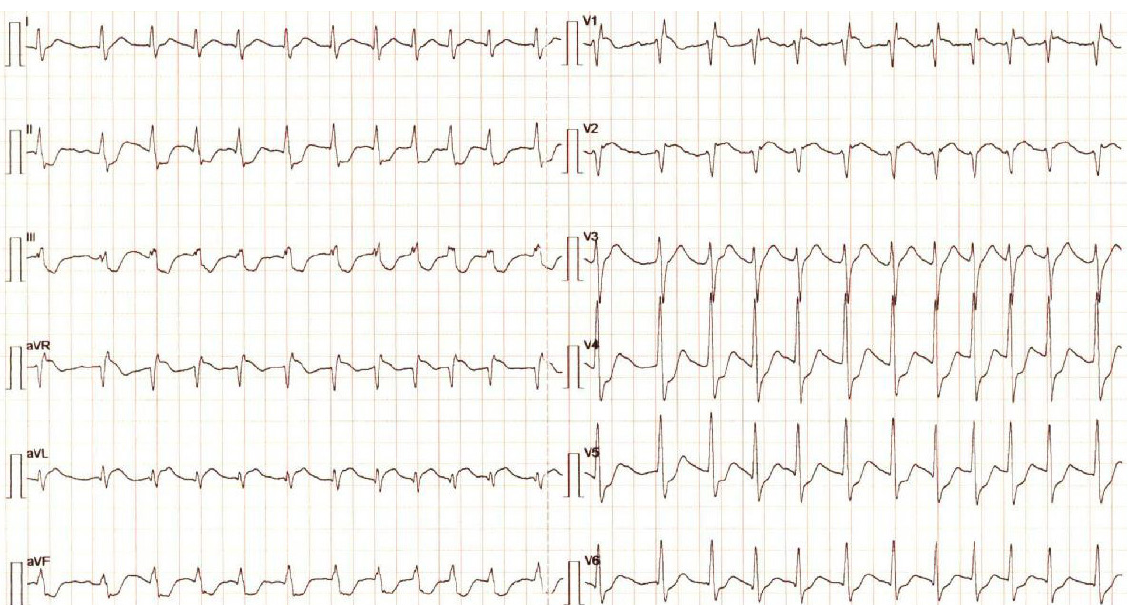
Image 1. Electrocardiogram showing a narrow complex tachycardia with 150 bpm, ST-segment elevation in leads aVR, V1, V2 and ST- segment depression in leads II, III, aVF and V4 to V6.